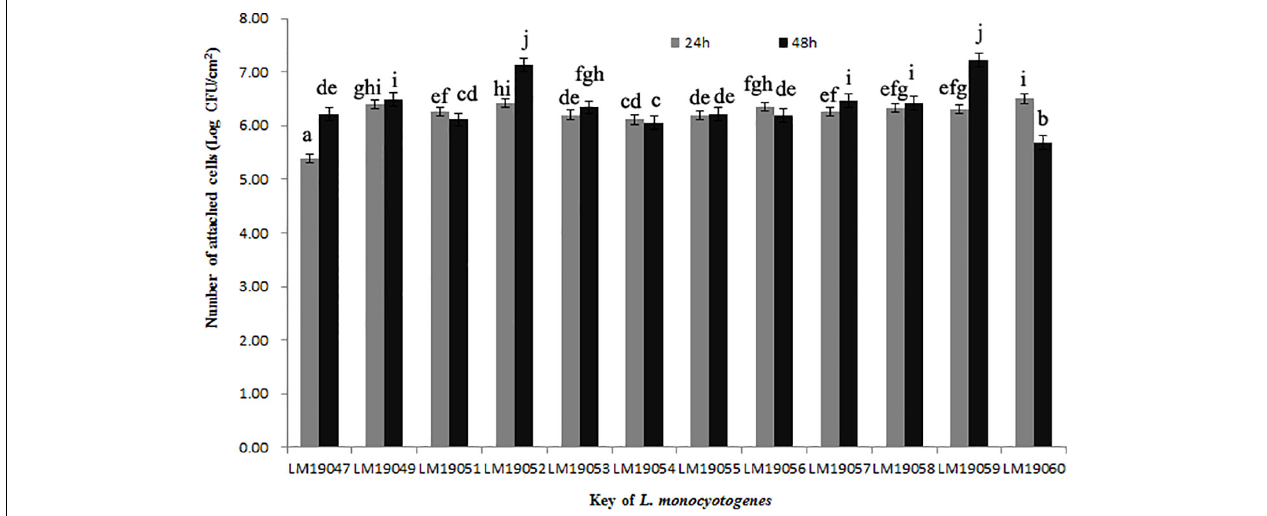
FIGURE 3 | Population (Log CFU/cm 2 ) of 12 L. monocytogenes isolates biofilms at 26 ◦ C on 24 and 48 h. Mean values at the different incubation time and different isolates with different lowercase letters are statistically different ( p <